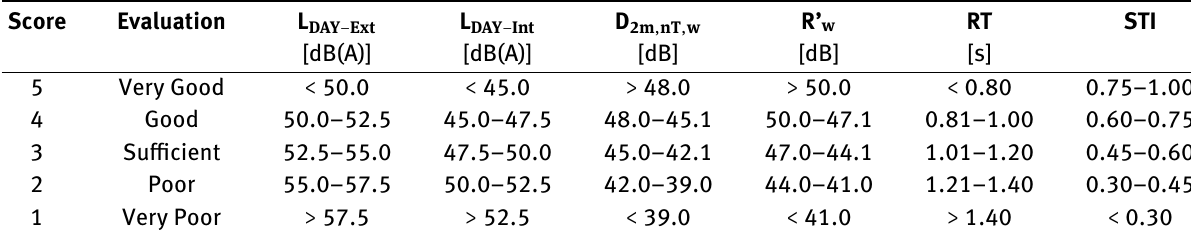
Table 3: Score ranges for each parameter. Score